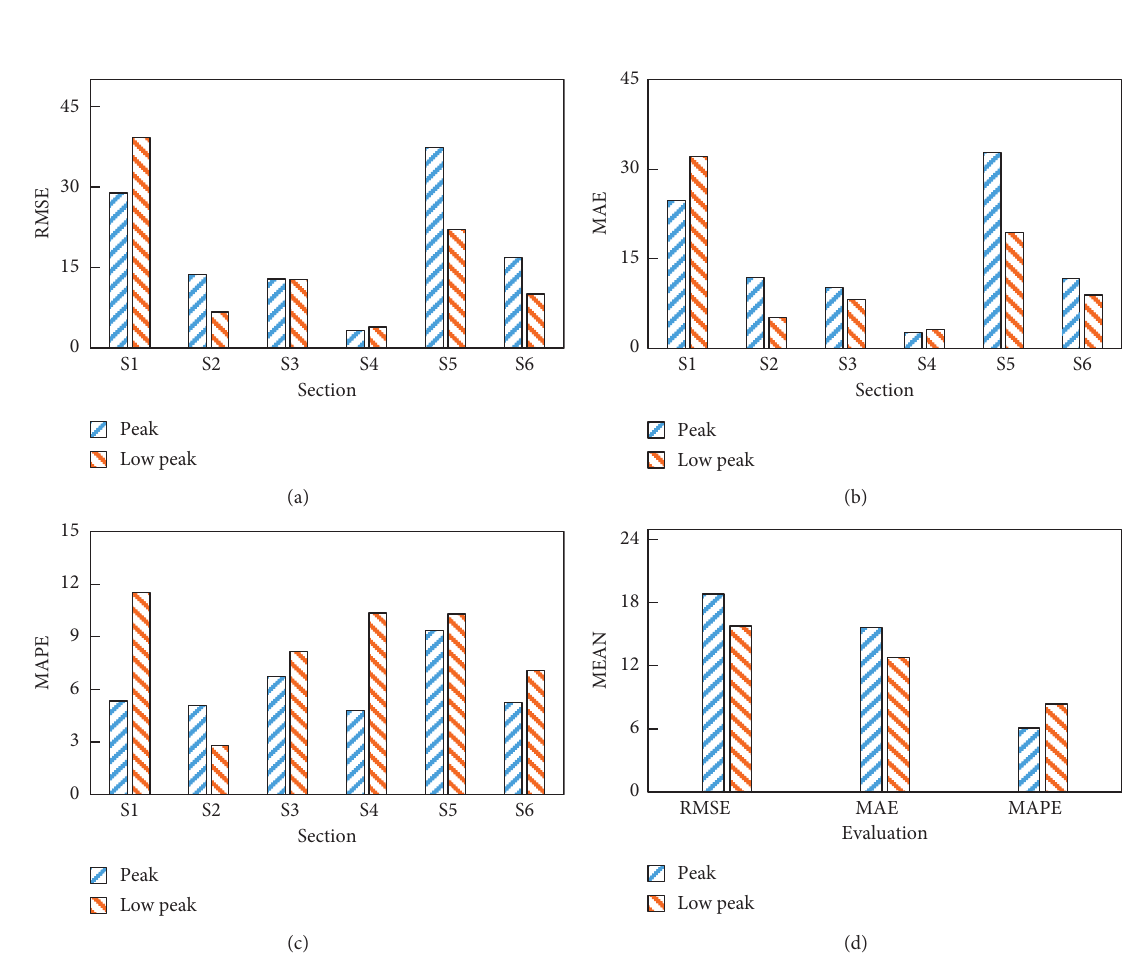
Figure 11: Prediction performance of peak and low peak.